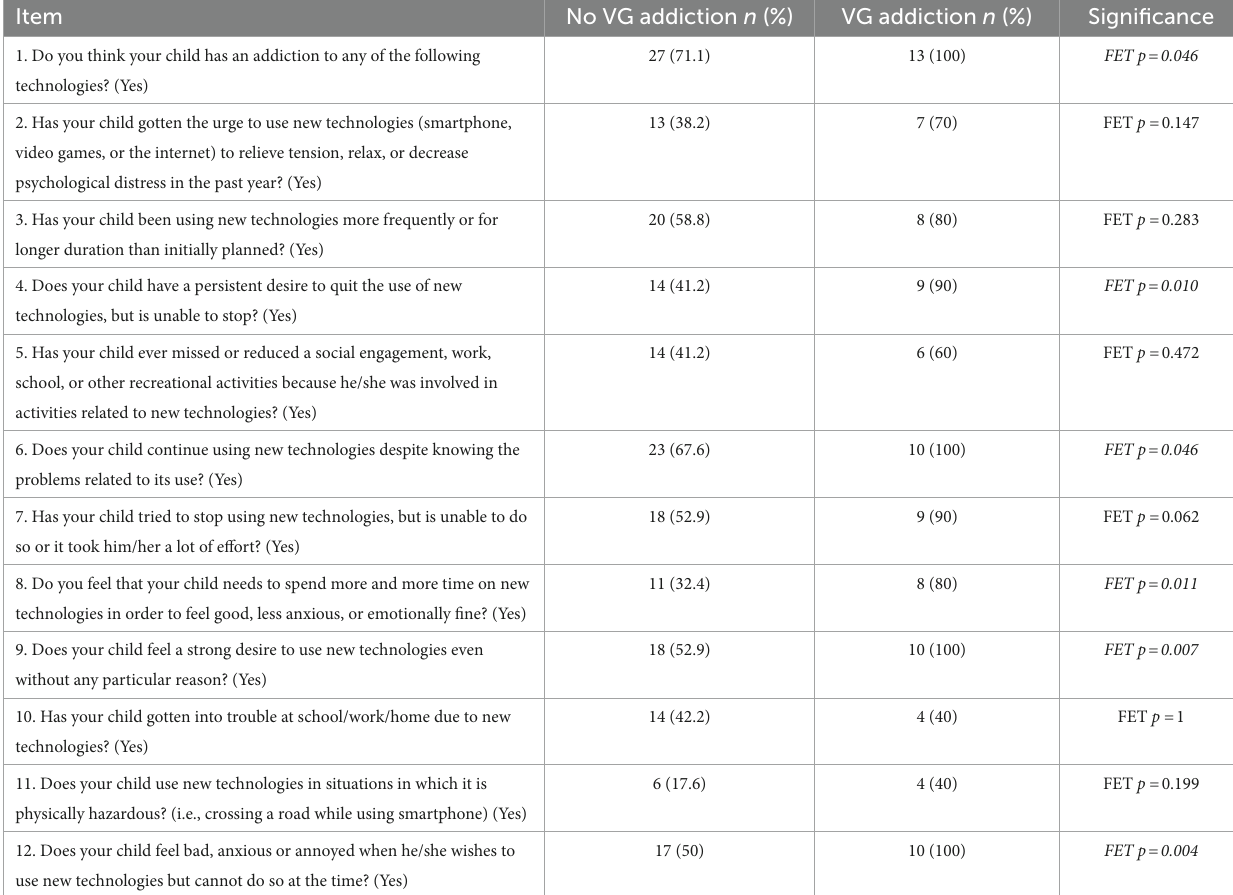
TABLE 5 Ad hoc questionnaire about a putative ANT